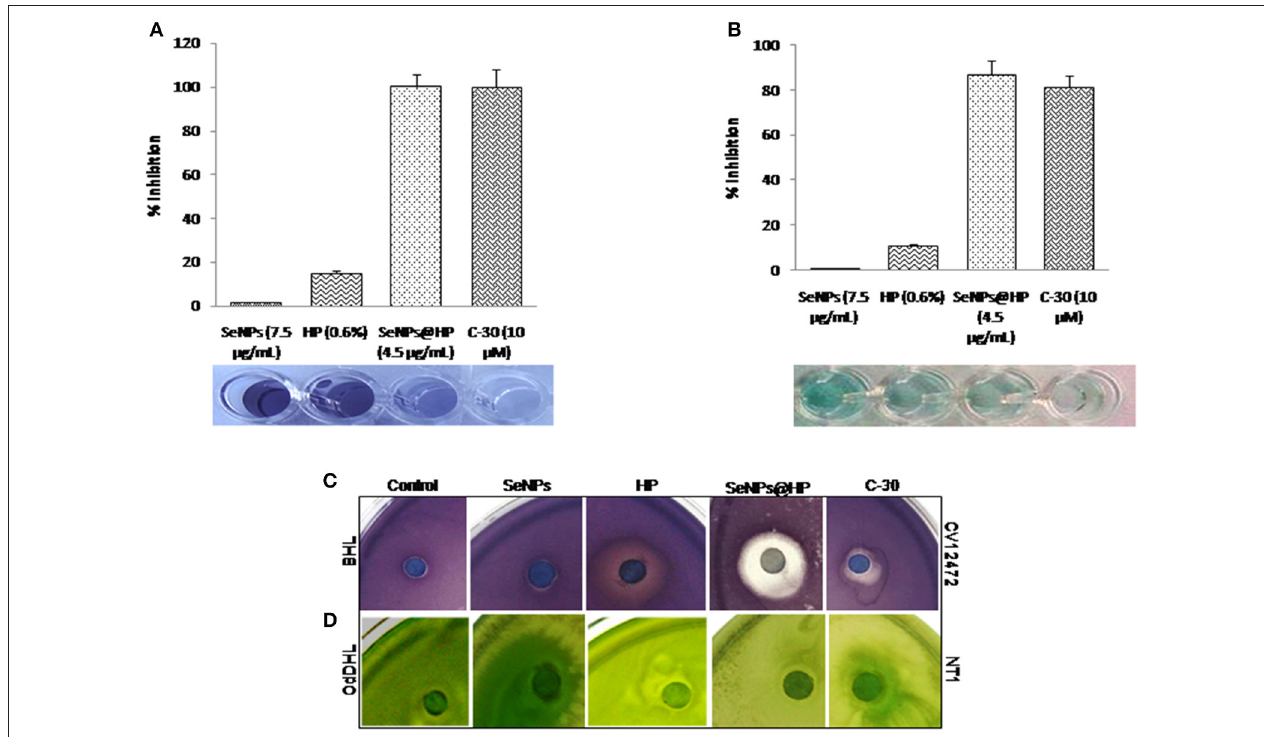
FIGURE 3 | Inhibition of QS by SeNPs@HP. Bioindicator strains of bacteria, C. violaceum CV12472 and A. tumefaciens NT1 were used for assaying anti-QS activity. Inhibition of color changes due to treatment of SeNPs (7.5 µ g/mL), HP (0.6%), SeNPs@HP (4.5 µ g/mL), and furanone C-30 (10 µ M) was quantified by measuring OD at 590 nm for CV12472 and 545 nm for NT1 bacteria. (A) Test samples-BHL competition and (B) test samples-OdDHL competition. Error bars indicate the standard deviations of 8 measurements. Inhibition of QS potential based on color inhibition was further examined on solid culture media and detail protocol has been described in Materials and Methods section. (C) Test samples-BHL competition against CV12472 and (D) test samples-OdDHL competition against